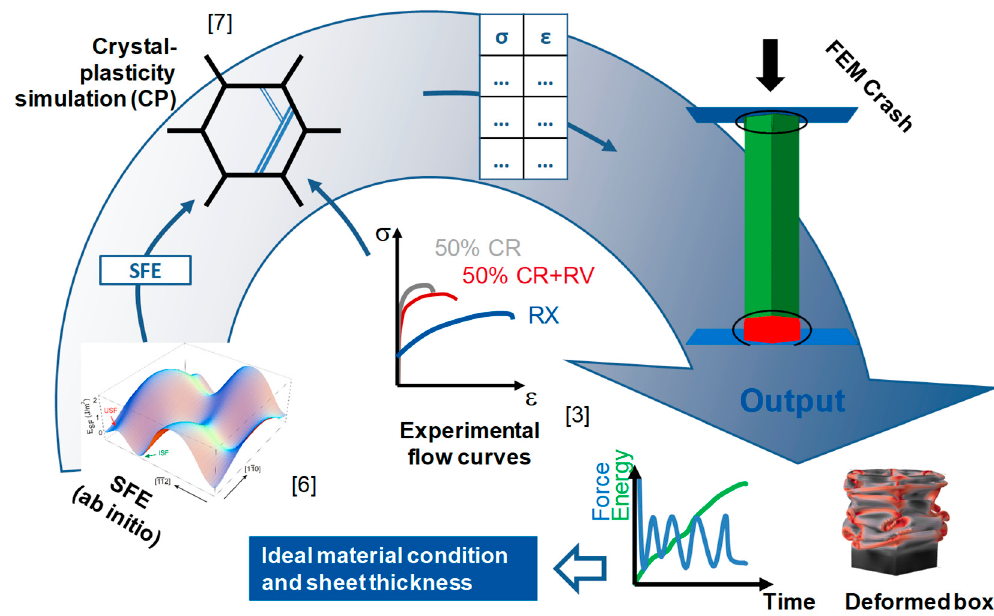
Figure 1. Multiscale simulation chain with ab initio calculation of stacking fault energy (SFE), crystal plasticity simulation for hardening behavior and finite element (FE) simulation for crash behavior. The references in the figure indicate the sources used for data acquisition.